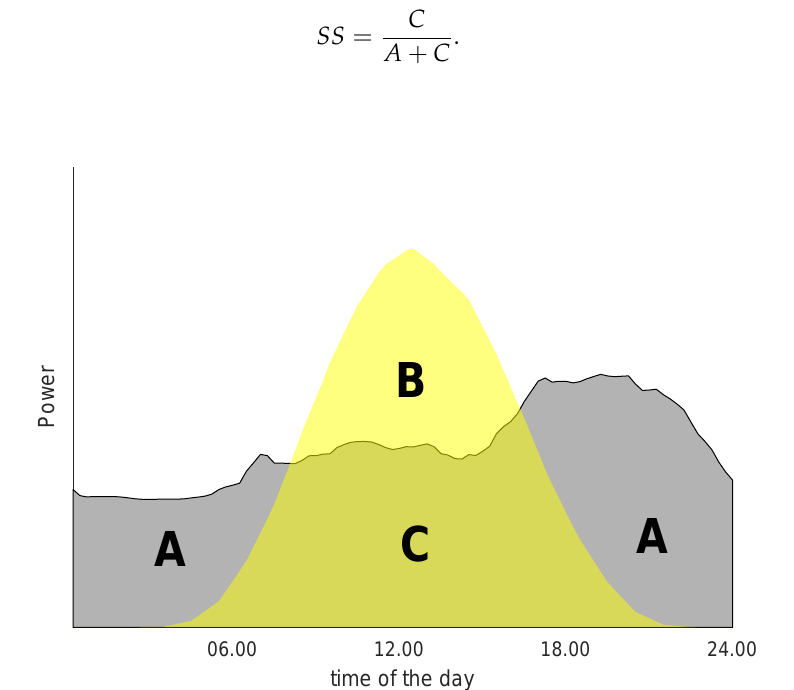
Figure 4. Schematic outline of daily load (A + C), PV generation (B + C), and self-consumed electricity